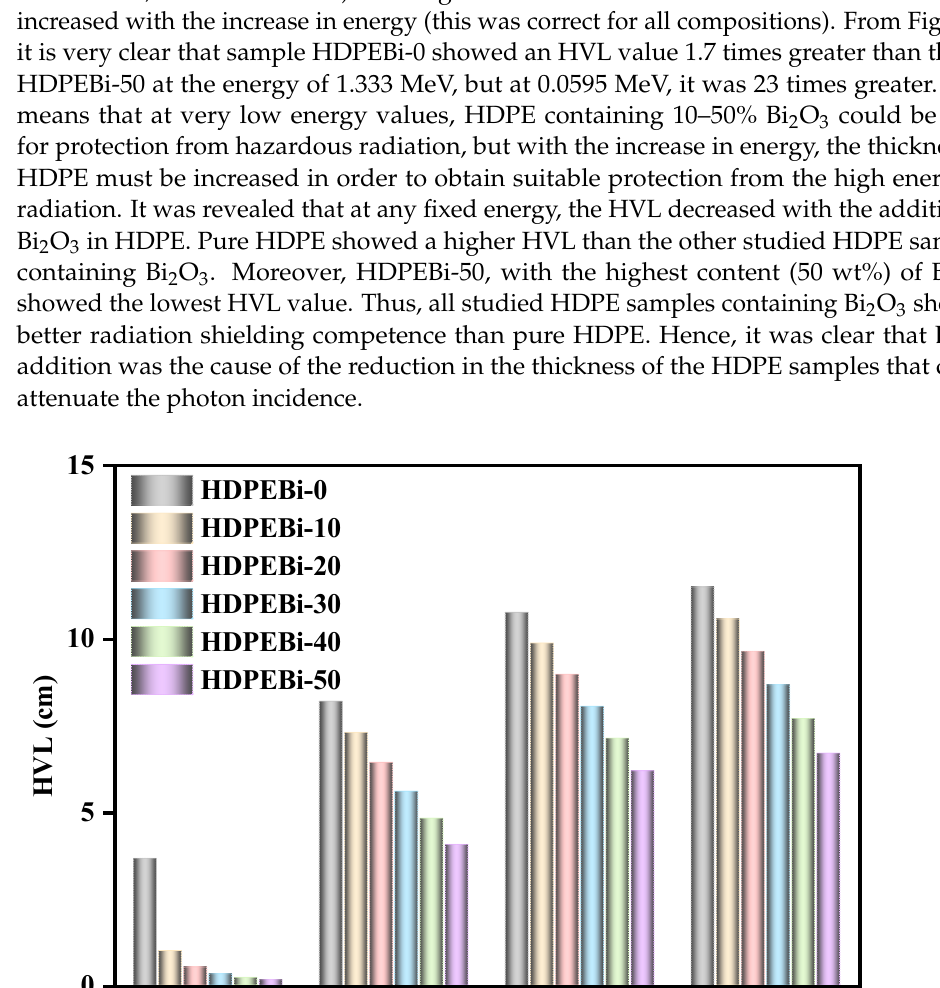
Co-60 gamma irradiation. HDPE system HDPEBi-50 (50 wt% Bi 2 O 3 ) had the lowermost systems improved with the addition of Bi 2 O 3